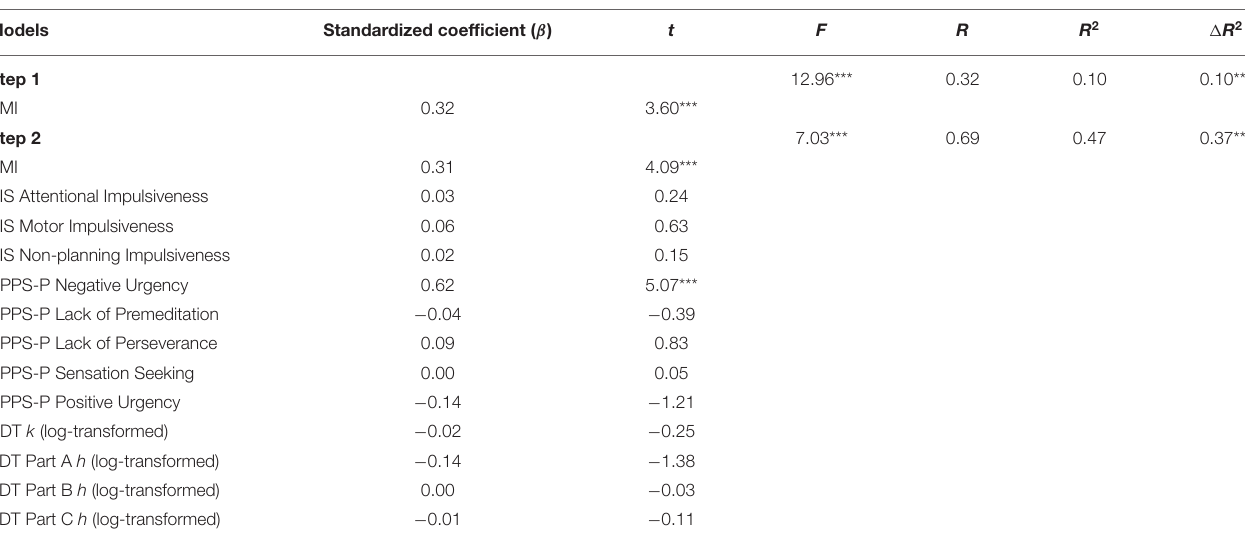
TABLE 3 | Multivariable linear regression analyses of impulsivity measures on BES scores ( N = 117).